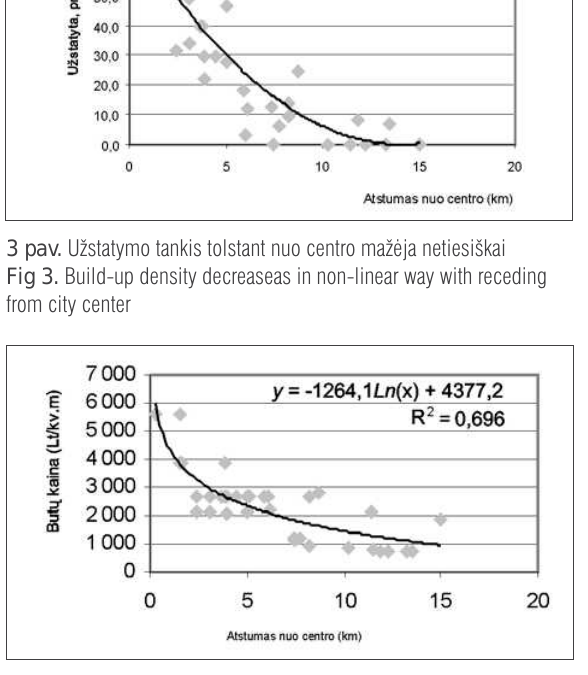
Kintamąjį X (atstumą nuo miesto centro) trans- 2